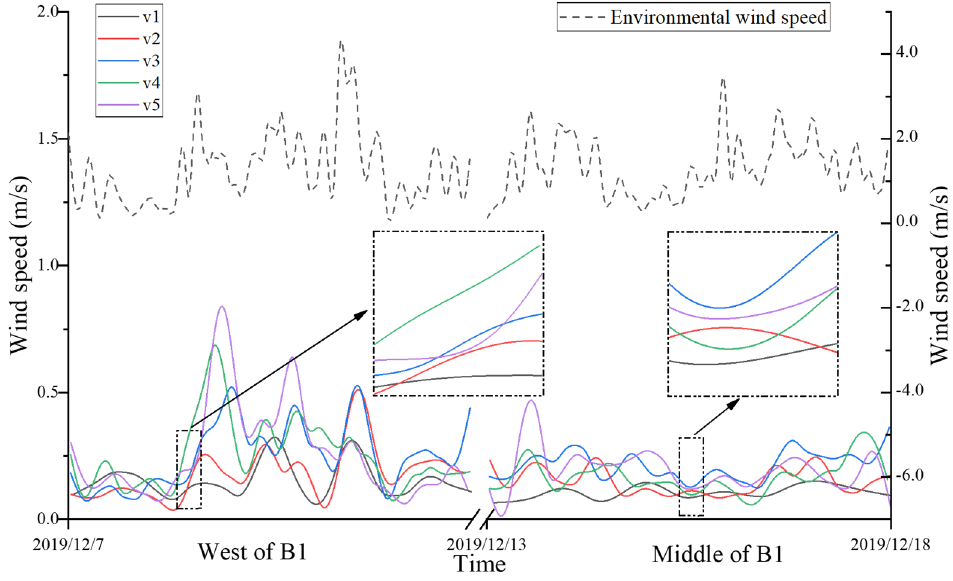
Figure 9. Changes of airflow velocity and environmental wind speed of B1.